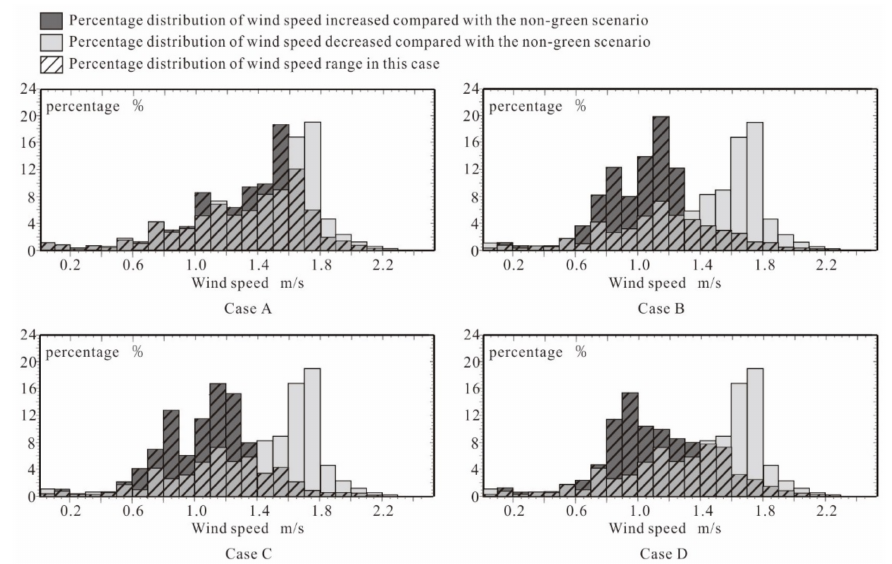
Figure 10. Percentage distribution of wind speed range in the residential district area at pedestrian height on 23 June at